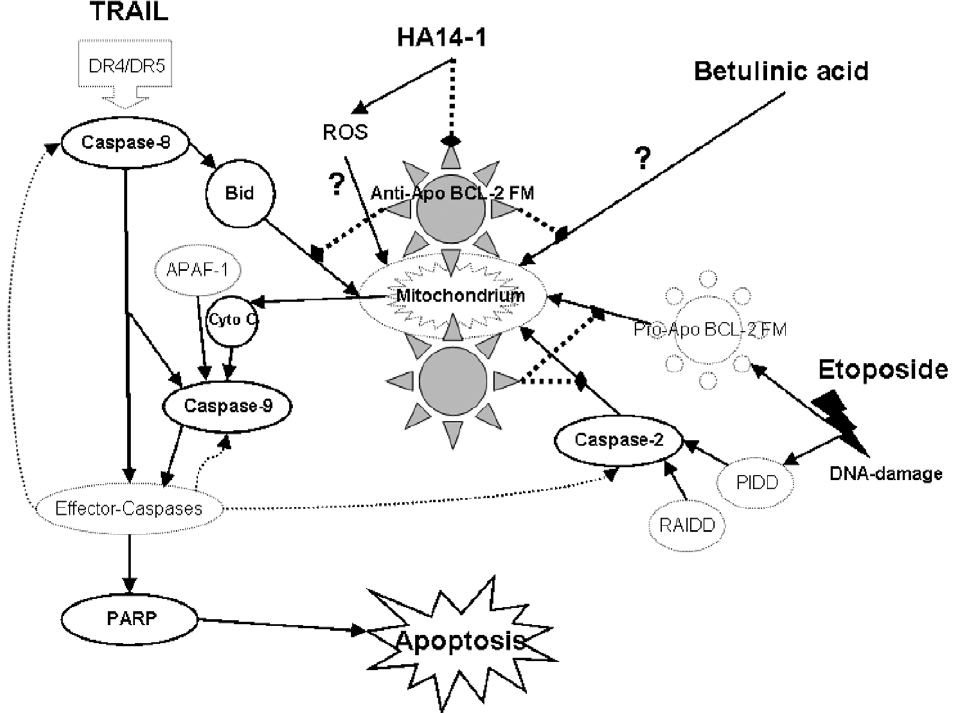
Fig. 8. Simplified diagram comprising the substances and apoptotic pathways investigated in this study. The substances and proteins analysed in this study are bold. The bold lines with arrow heads mean induction or activation, the bold dotted lines with diamond heads mean inhibition. Feedback loops are marked by thin curved dotted lines with arrow heads. (This diagram is simplified and makes no claim to be complete.) Abbreviations: Anti-Apo BCL-2 FM – antiapoptotic BCL-2 family members; Cyto C – cytochrome C; Pro-Apo BCL-2 FM – proapoptotic BCL-2 family